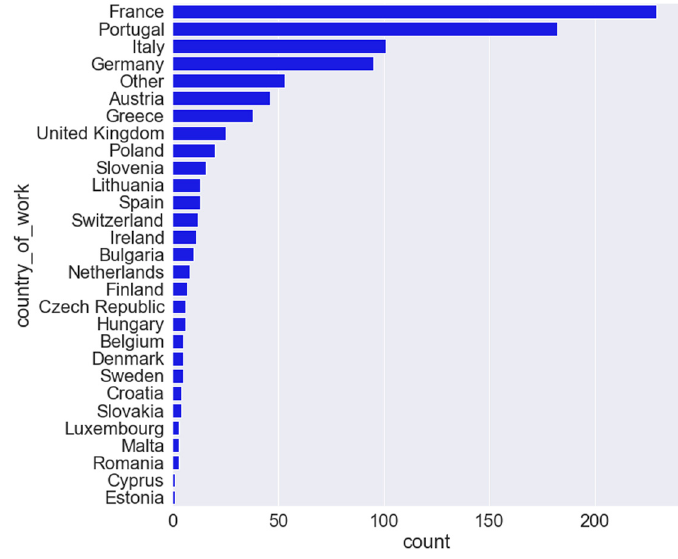
Figure 8. Country of work.